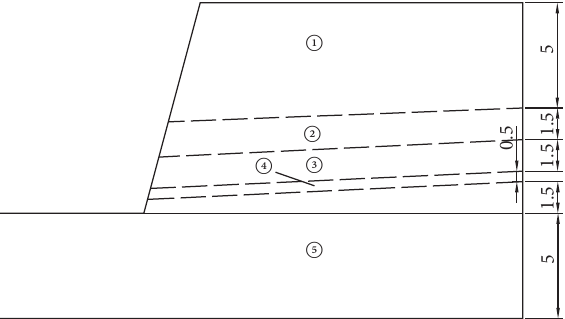
Figure 10: Schematic diagram of the distribution of rock layers (unit: layer in the plumb direction was approximately equal to the